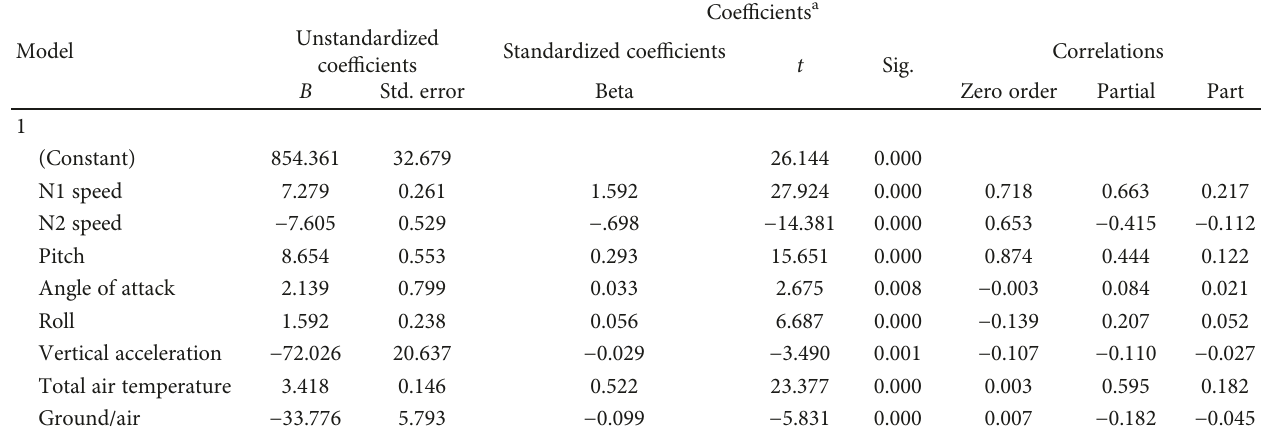
Table 7: Multiple regression analysis results for EGT training